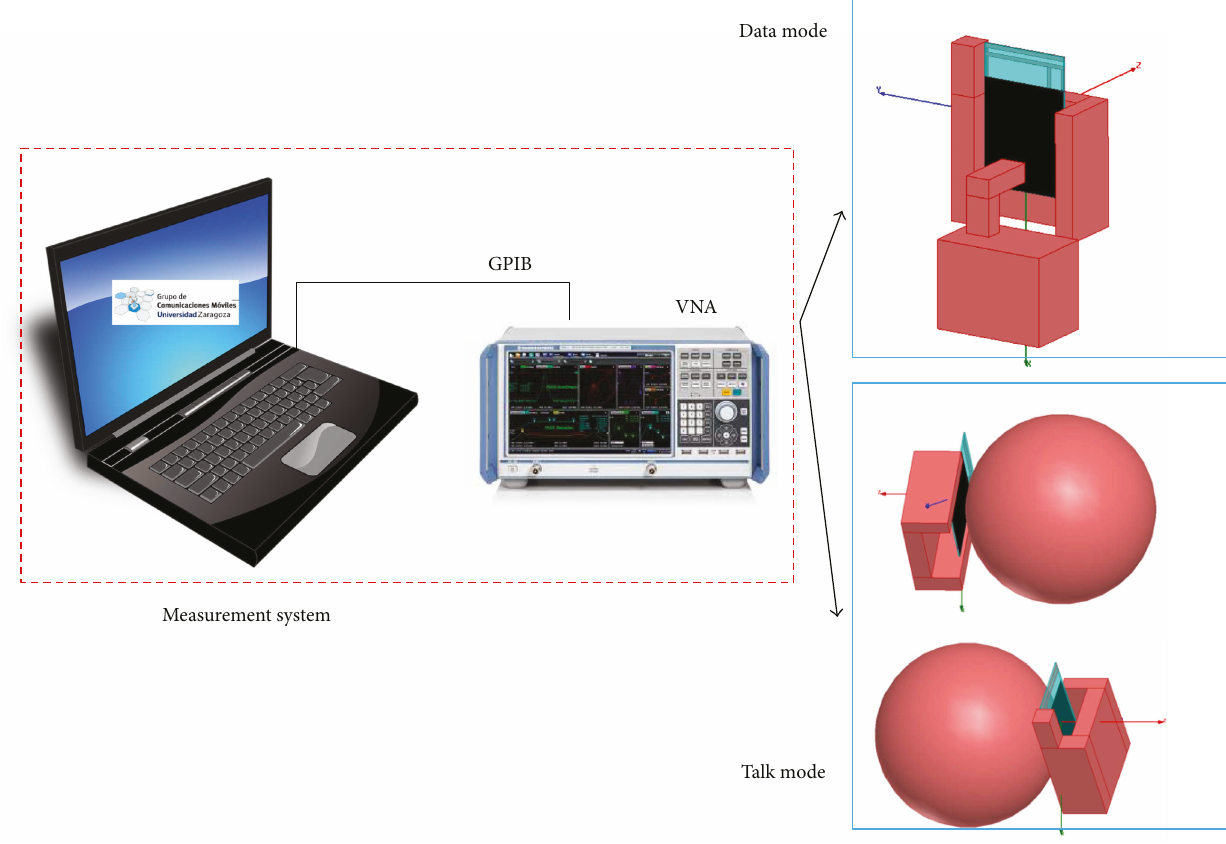
Figure 1: Typical antenna coupling modes for wireless